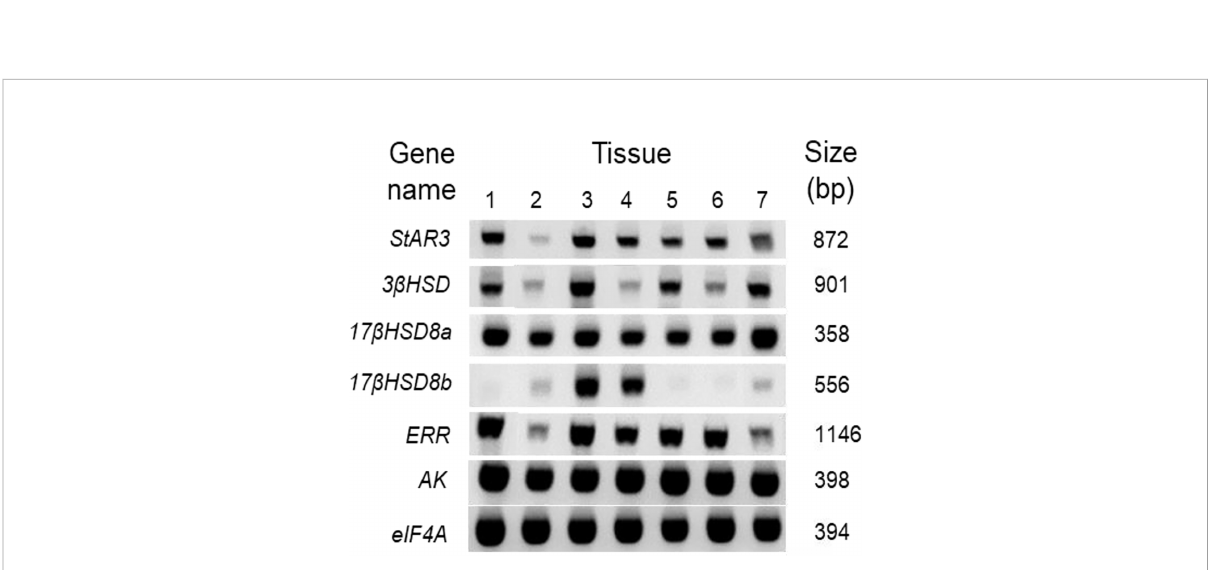
FIGURE 7 Spatial distribution of vertebrate steroidogenic genes in the tissues of an adult female C. sapidus . Each cDNA tissue sample containing 12.5 ng total RNA equivalent was ampli fi ed by PCR. The PCR products were analyzed on 1.5% agarose gel and stained with ethidium bromide. The tissues are noted as: 1 = eyestalk ganglia, 2 = hepatopancreas, 3 = brain, 4 = ovary, 5 = spermathecae, 6 = ovigerous setae, 7 = plumose